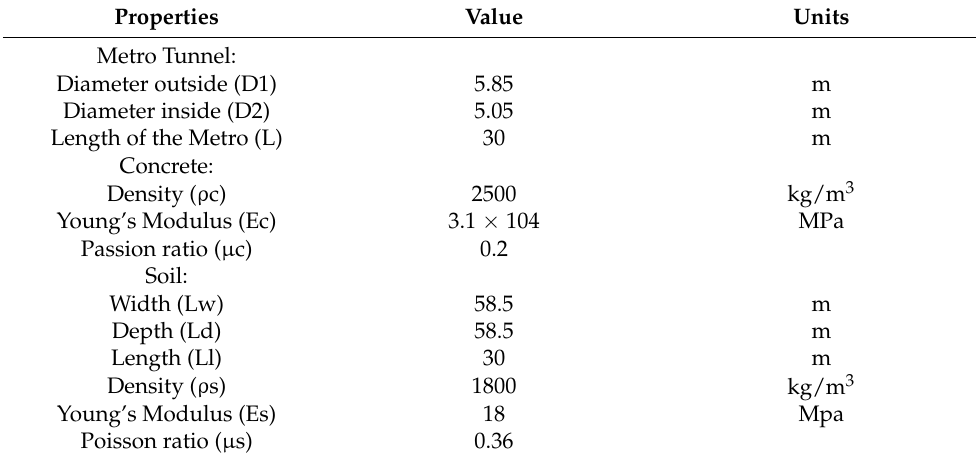
Table 4. Material properties and unit values.